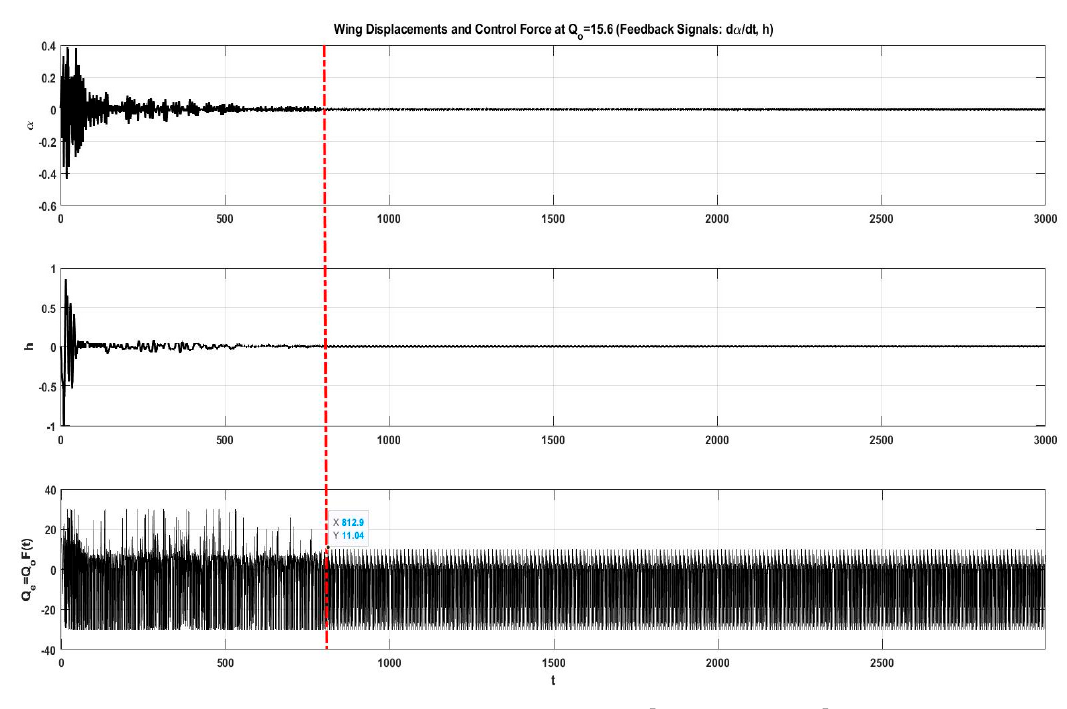
Figure 13. Closed-loop aeroelastic response ( 𝑄 (cid:3032) = 𝑄 (cid:3042) (cid:4670)cos(𝛼(cid:4662) 𝑡) + sin(ℎ𝑡)(cid:4671) , 𝑄 (cid:3042) = 15.6 ).